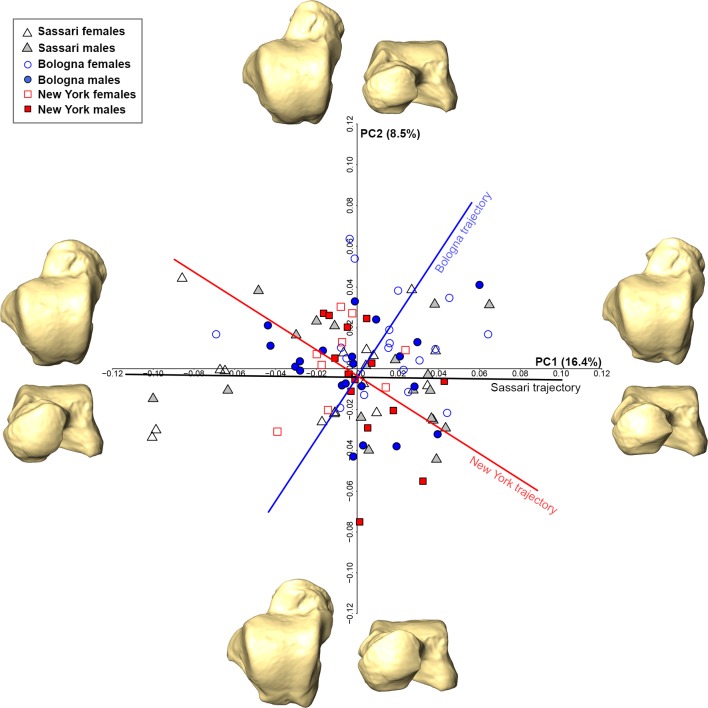
Shape space PCA plot of the pooled sample and shape warps along axes.Sassari individuals are in black, Bologna individuals in blue and New York individuals in red. Intragroup allometric trajectory (black for Sassari, blue for Bologna and red for New York) are shown in the PCA plot. The deformed mean tali in the four directions of the PCs are drawn at the extremity of each axis.